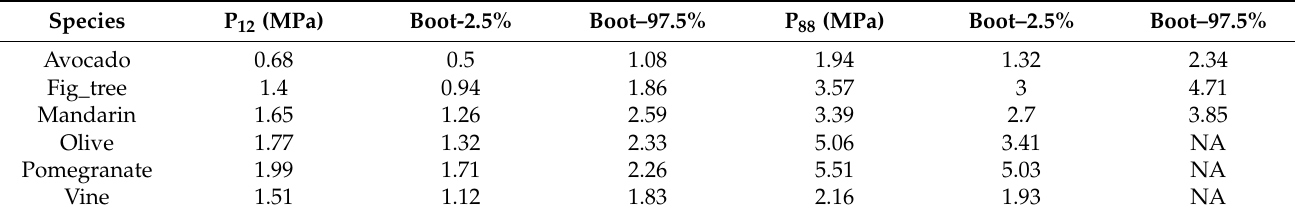
Table A1. Leaf hydraulic vulnerability curve parameter.